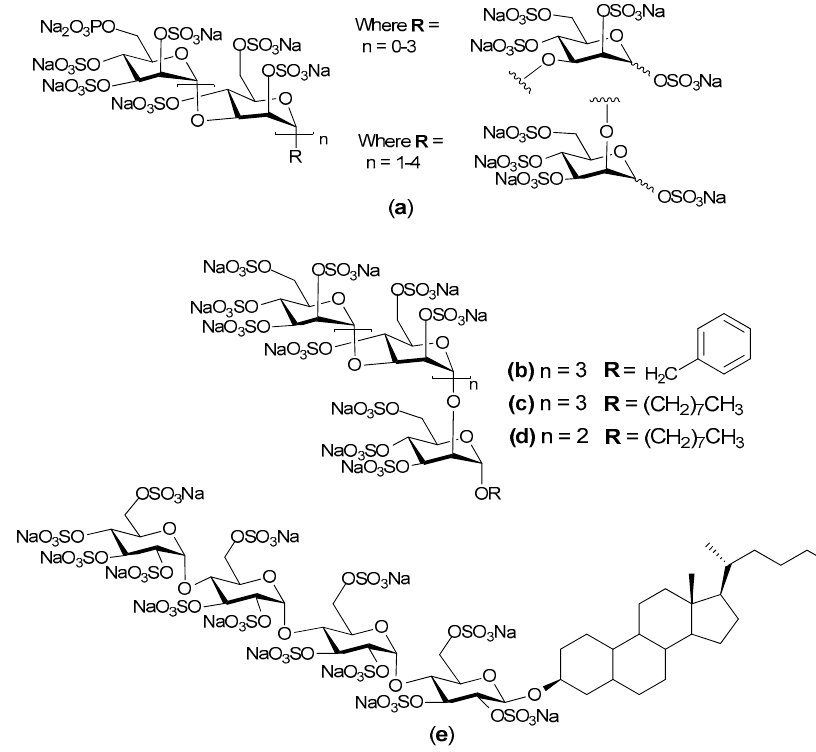
Figure 5. ( a ) Generalized chemical structure of PI-88; ( b – d ) Analogues of PI-88; ( e ) Chemical structure of PG545.